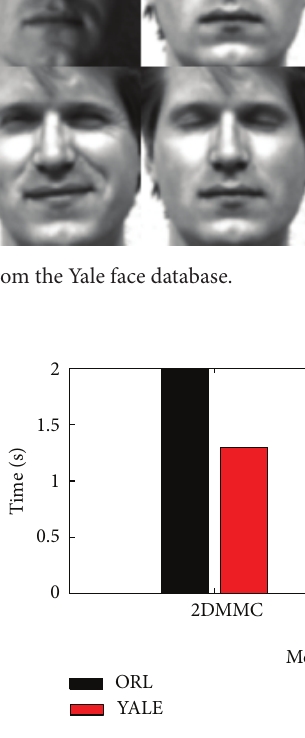
Figure 4: Training time of two methods on ORL and Yale datasets with TN = 2